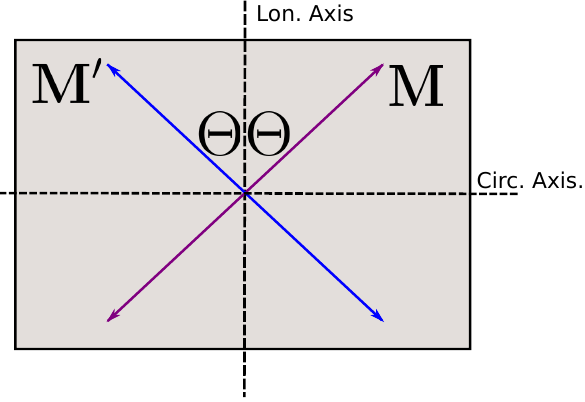
Figure 2. Longitudinal symmetry of the fiber family in the material configuration.